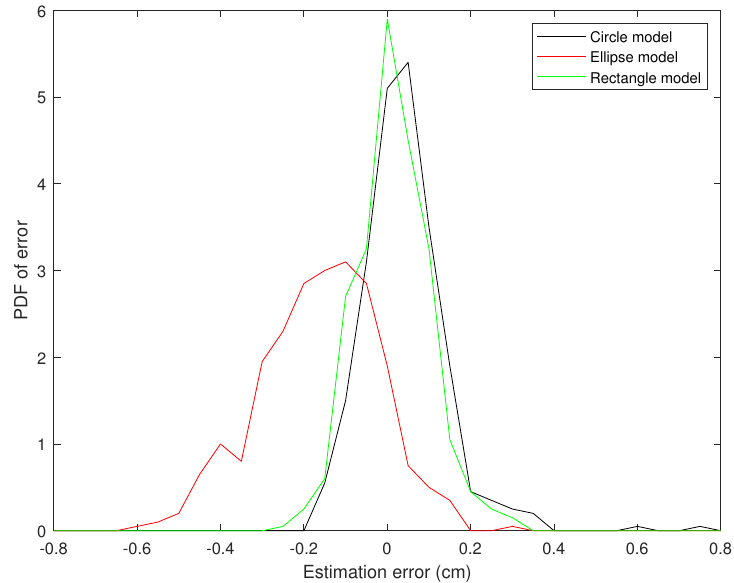
Figure 9. PDF of the AP-diameter estimation error w.r.t. manual measurement for the first sample video depicted in Figure 5, as measured by active circle algorithm (black line), active ellipse algorithm (red line) and active rectangle algorithm (green line).